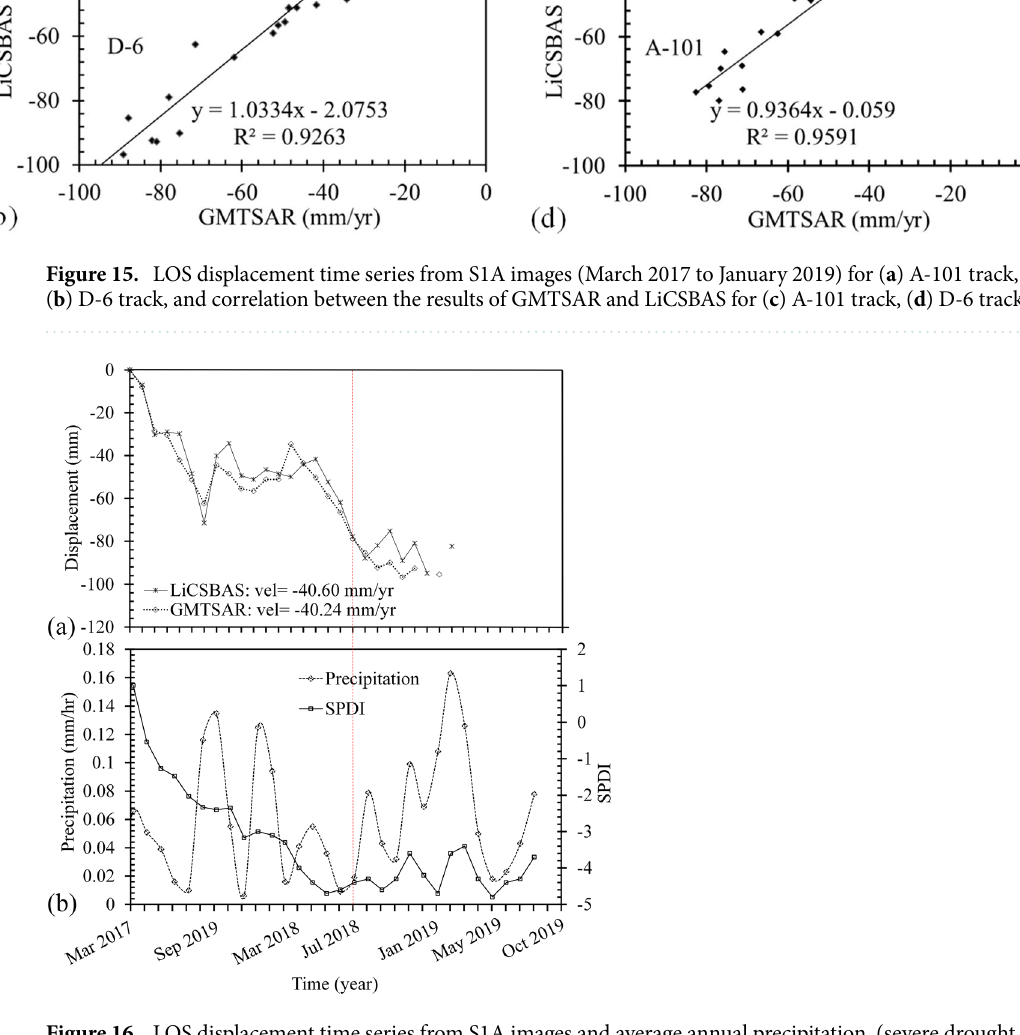
Figure 16. LOS displacement time series from S1A images and average annual precipitation, (severe drought from March 2017 to January